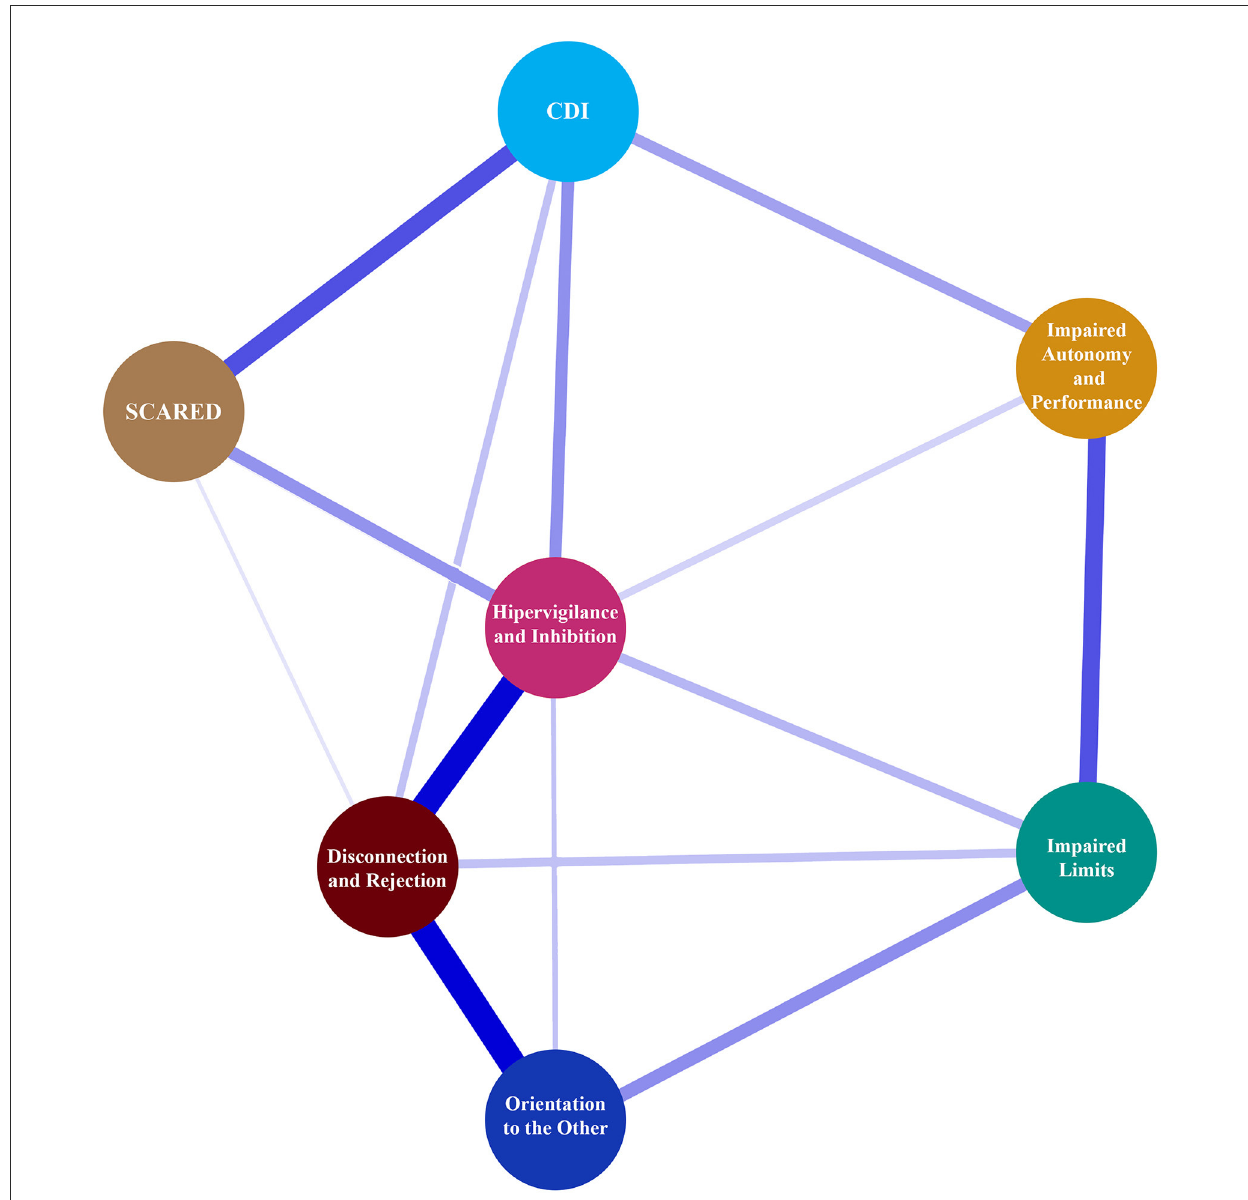
FIGURE3 Network plot for adolescents between CDI, SCARED, and EMS domain with episodic